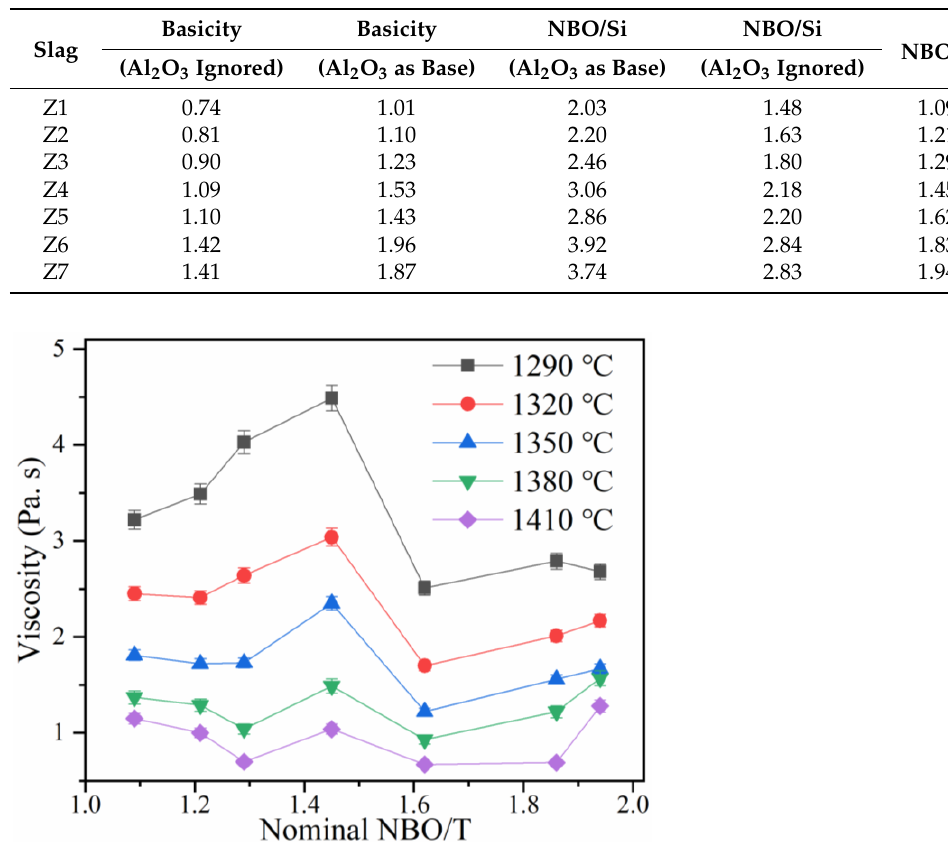
Table 3. Calculated O/Si, NBO/Si, and NBO/T values of different slags (mol).